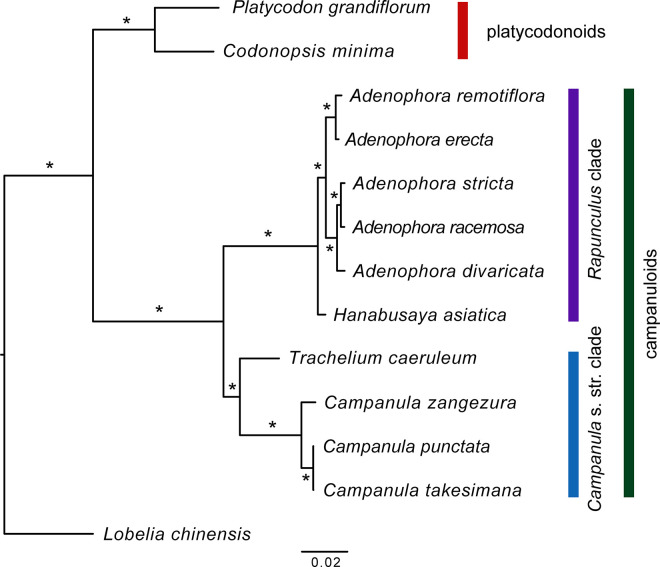
The ML tree based on 76 protein coding genes from 13 chloroplast genomes.The 100% bootstrap (BP) value and 1.00 Posterior probability (PP) value are marked with *.